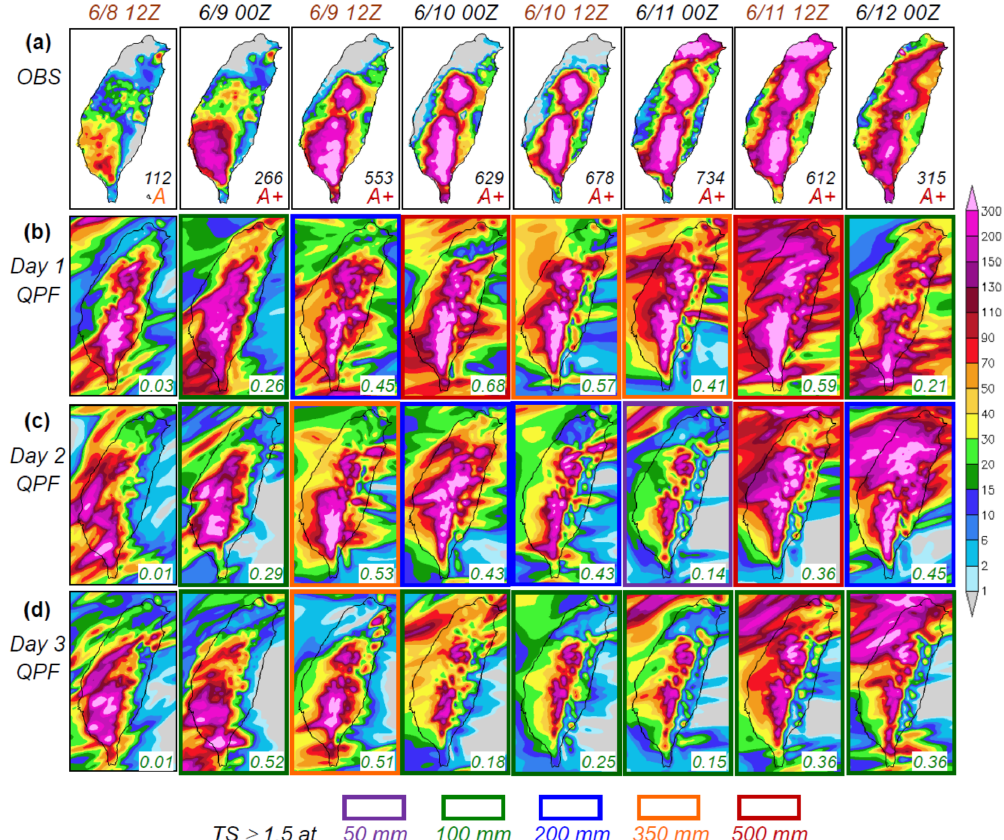
Figure 6. (a) The observed 24h accumulated rainfall (mm; scale on the right) over Taiwan from 12:00UTC 8 June to 00:00UTC 13 June 2012, given every 12h (from left to right), with the beginning time of accumulation (UTC) labeled on top (black for 00:00– 24:00UTC and brown for 12:00–12:00UTC). (b) Day − 1 (0–24h), (c) day − 2 (24–48h), and (d) day − 3 (48–72h) QPFs valid for the same 24h periods as shown in (a) by the 2.5km CReSS (starting at 00:00 or 12:00UTC under black or brown headings, respectively). In (a) , peak 24h rainfall (mm) and classification group are labeled. In (b) – (d) , thick boxes in purple, green, blue, orange, and scarlet denote forecasts having a TS ≥ 0.15 at the threshold of 50, 100, 200, 350, and 500mm (per 24h), respectively, and the TS at 100mm is also given (lower right